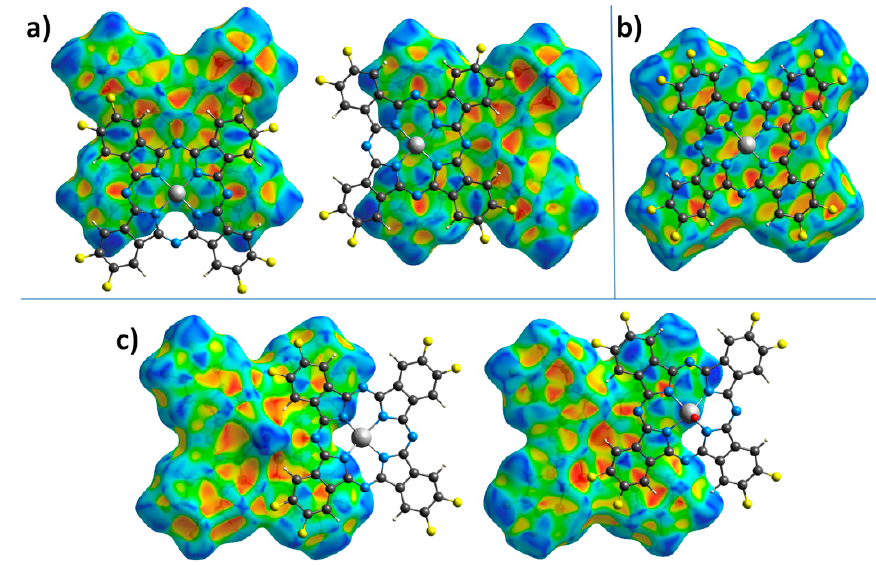
Figure 5. Hirshfeld surfaces for ZnPcF 8 ( a ), CoPcF 8 ( b ), and VOPcF 8 ( c ) molecules, mapped with the shape index property.